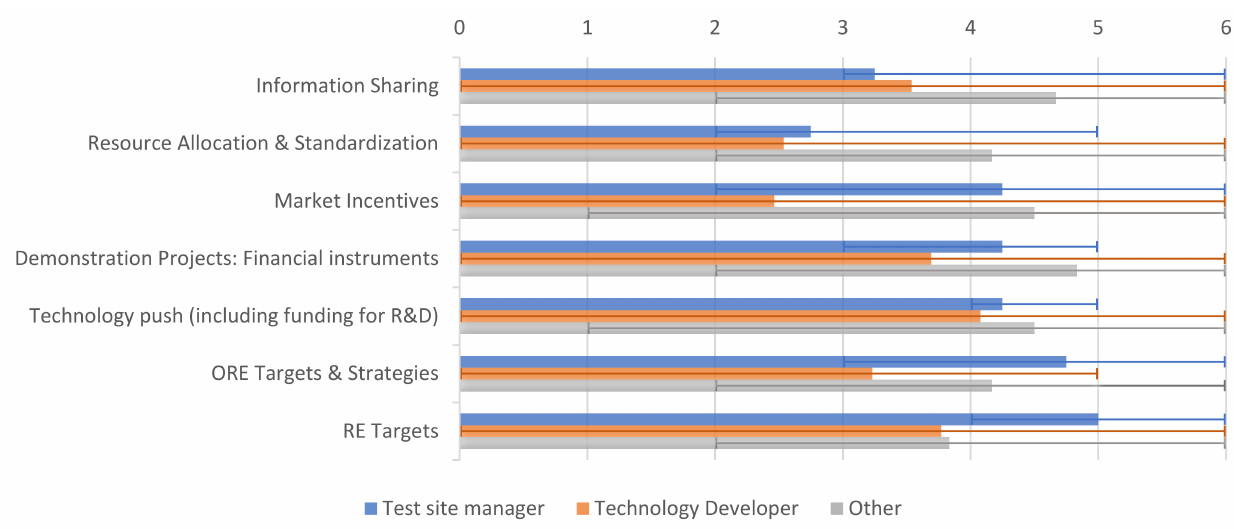
Figure 5. International policy mechanisms—respondents’ perceptions in respect to enabling potential of EU policy mech- anisms. Shaded bars show mean result; error bars show range of responses. (0: no enabling potential; 6: significant enabling